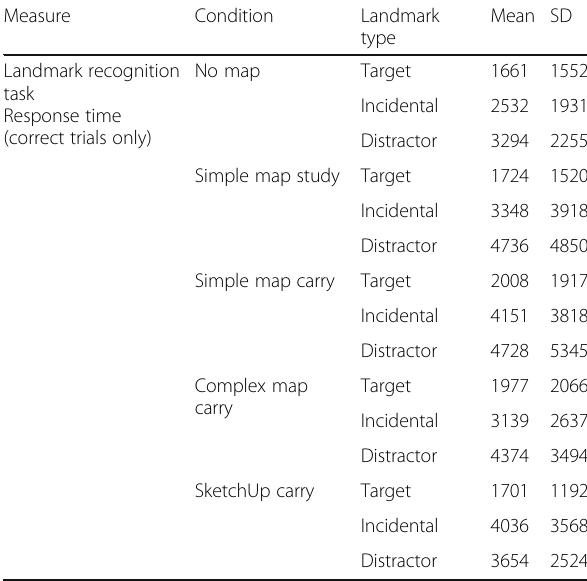
Table 5 Response times for correct responses to memory test trials, split by landmark type and map condition